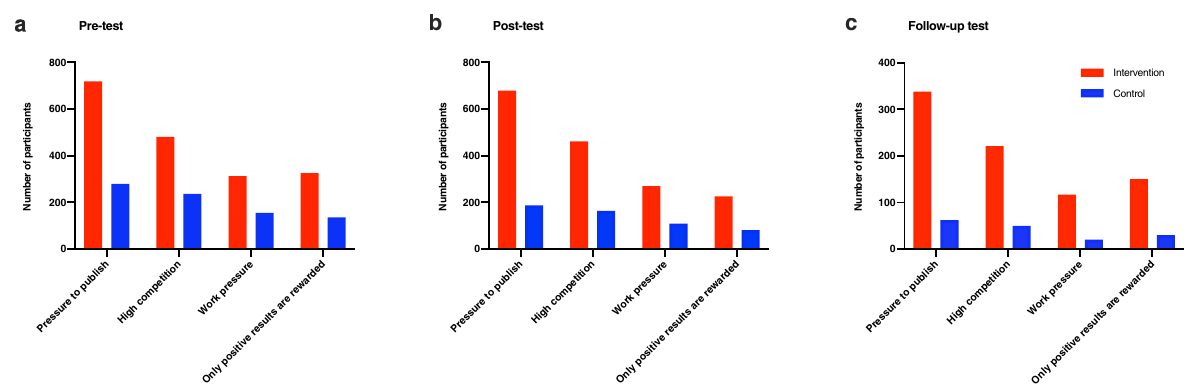
Fig. 3 Participants ’ attitudes for what they believe are the three most important reasons why researchers engage in research misconduct from a list of prede fi ned options, including option “ other ” . Pre-test indicates responses immediately prior to the course on research integrity ( a ). Post-test indicates responses immediately after the course ( b ). Follow-up indicates responses after 3 months ( c ). Data are shown as number of participants. Participants are PhD students in the intervention group and Master students in the control group.